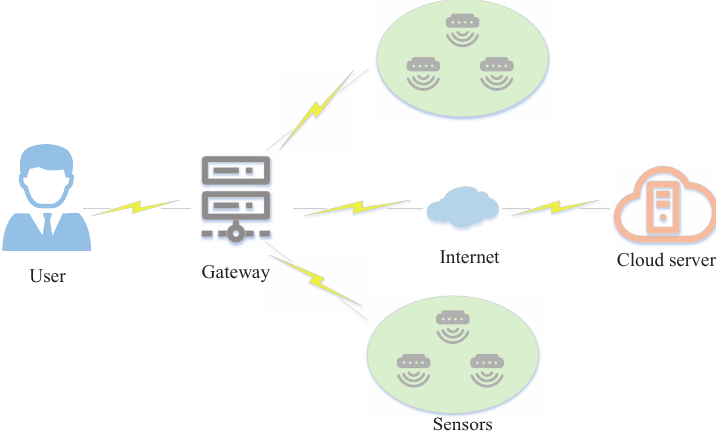
Figure 4. User and Device Authentication in